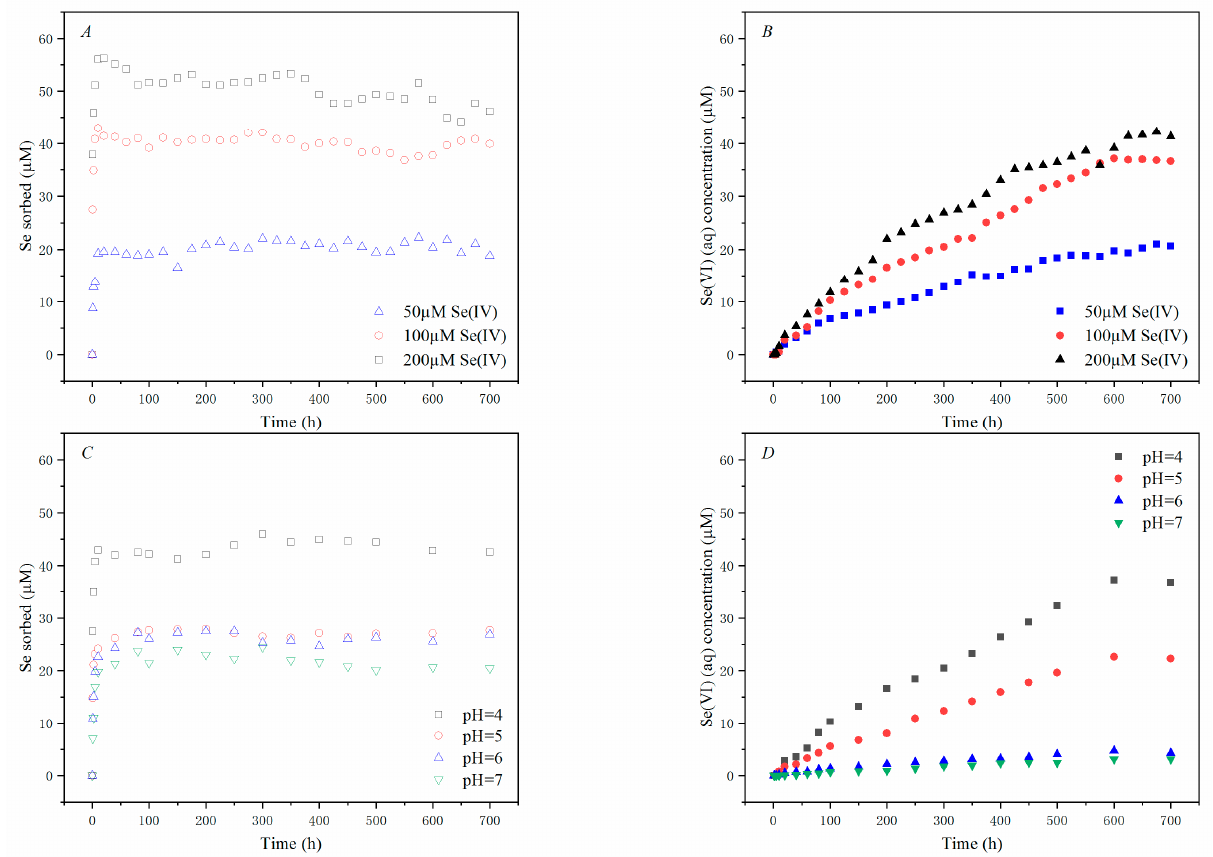
Figure 1. The effects of initial concentrations of Se(IV) and solution pH on the adsorption and oxidation of Se(IV) by δ -MnO 2 in batch experiments. ( A ) Se(IV) adsorbed; ( B ) Se(VI) (aq) concentration with initial Se(IV) concentrations of 50, 100, and 200 µ mol L − 1 ; δ -MnO 2 dosages of 10 g L − 1 in a pH 4 acetate buffer; ( C ) Se adsorbed; ( D ) Se(VI) (aq) concentration with a pH of 4, 5, 6, and 7, initial Se(IV) concentrations of 100 µ mol L − 1 , and δ -MnO 2 dosages of 10 g L − 1 .